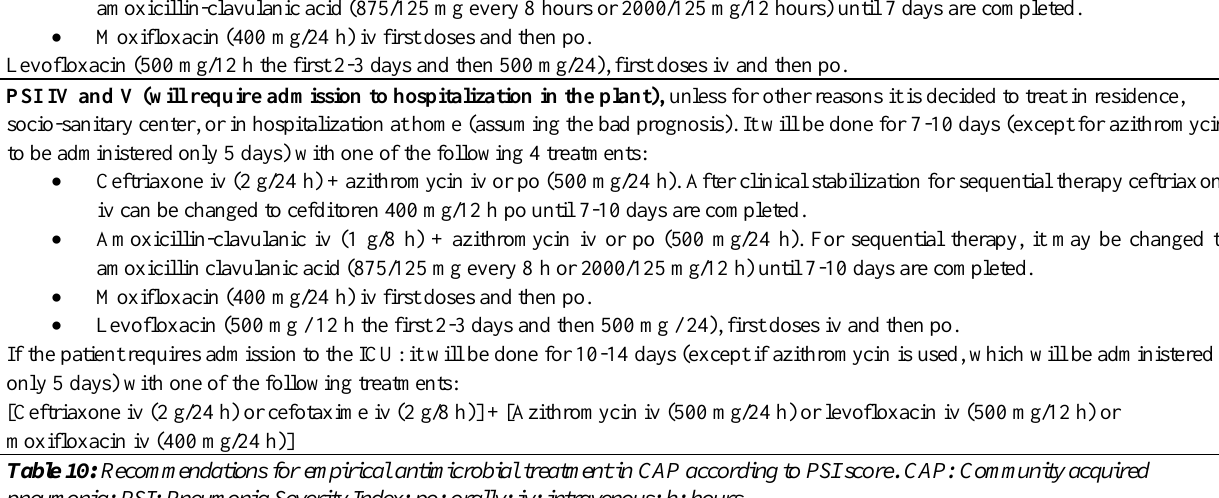
Table 10: Recommendations for empirical antimicrobial treatment in CAP according to PSI score. CAP: Community acquired pneumonia; PSI: Pneumonia Severity Index; po: orally; iv: intravenous; h: